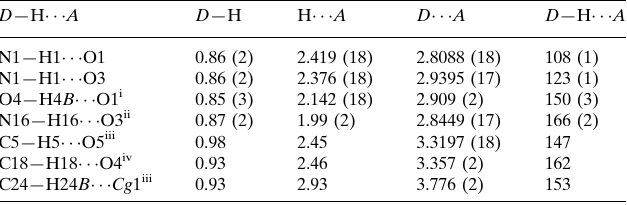
Hydrogen-bond geometry (A˚ , (cid:4)